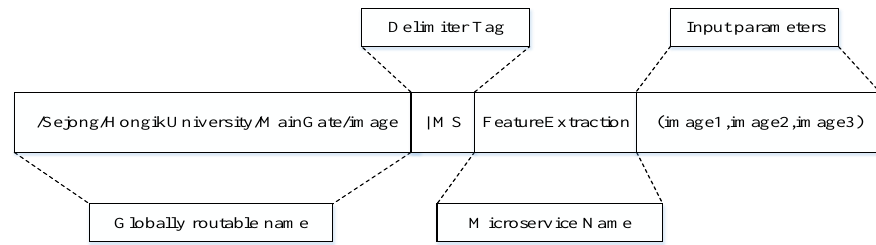
Figure 3. Microservice-centric interest packet structure.